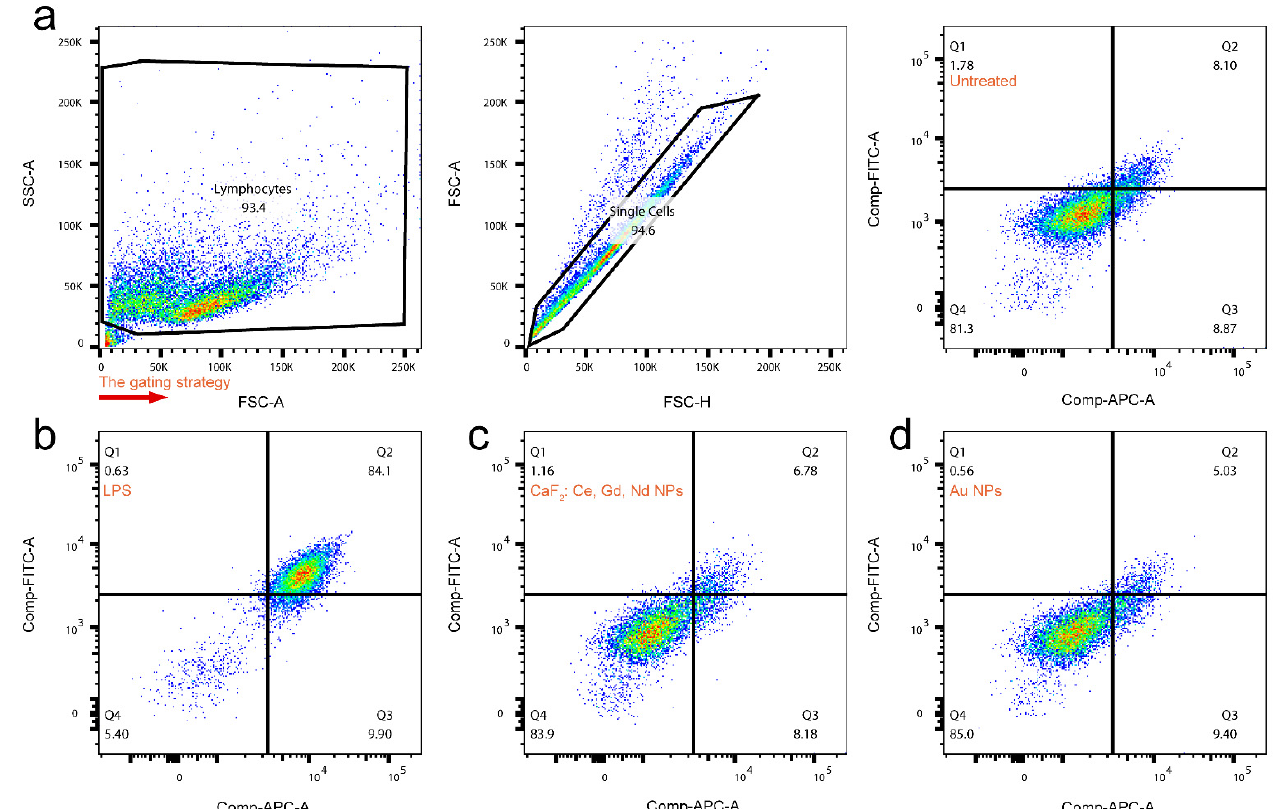
Figure 6. In vitro D1DC activation of CaF 2 : Ce, Gd, Nd NPs measured with FACS flow cytometry. D1DCs were incubated with samples for 24 h. ( a ) Gating strategy of D1DCs; ( b ) LPS (1 µ g/mL) incubate with D1DCs as the positive control; ( c ) CaF 2 : Ce, Gd, Nd NPs (125 µ g/mL) incubate with D1DCs; ( d ) Au NPs (125 µ g/mL) incubate with D1DCs as the negative control.